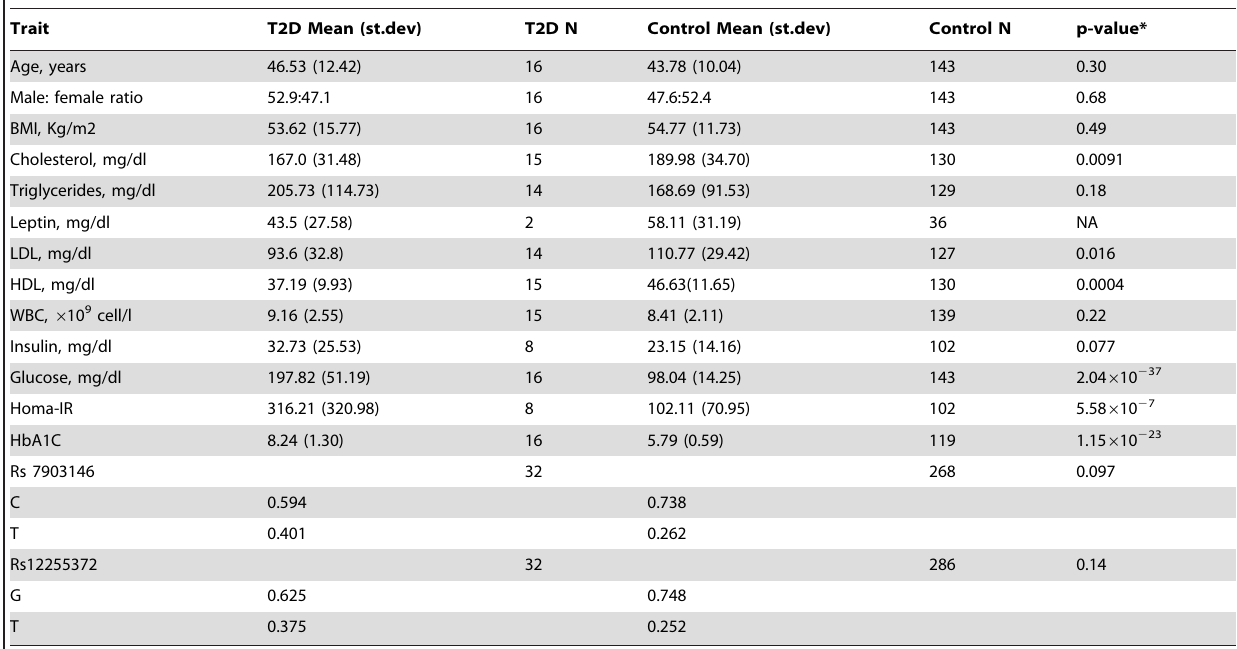
Table 1. Characteristics of the T2D and control groups.